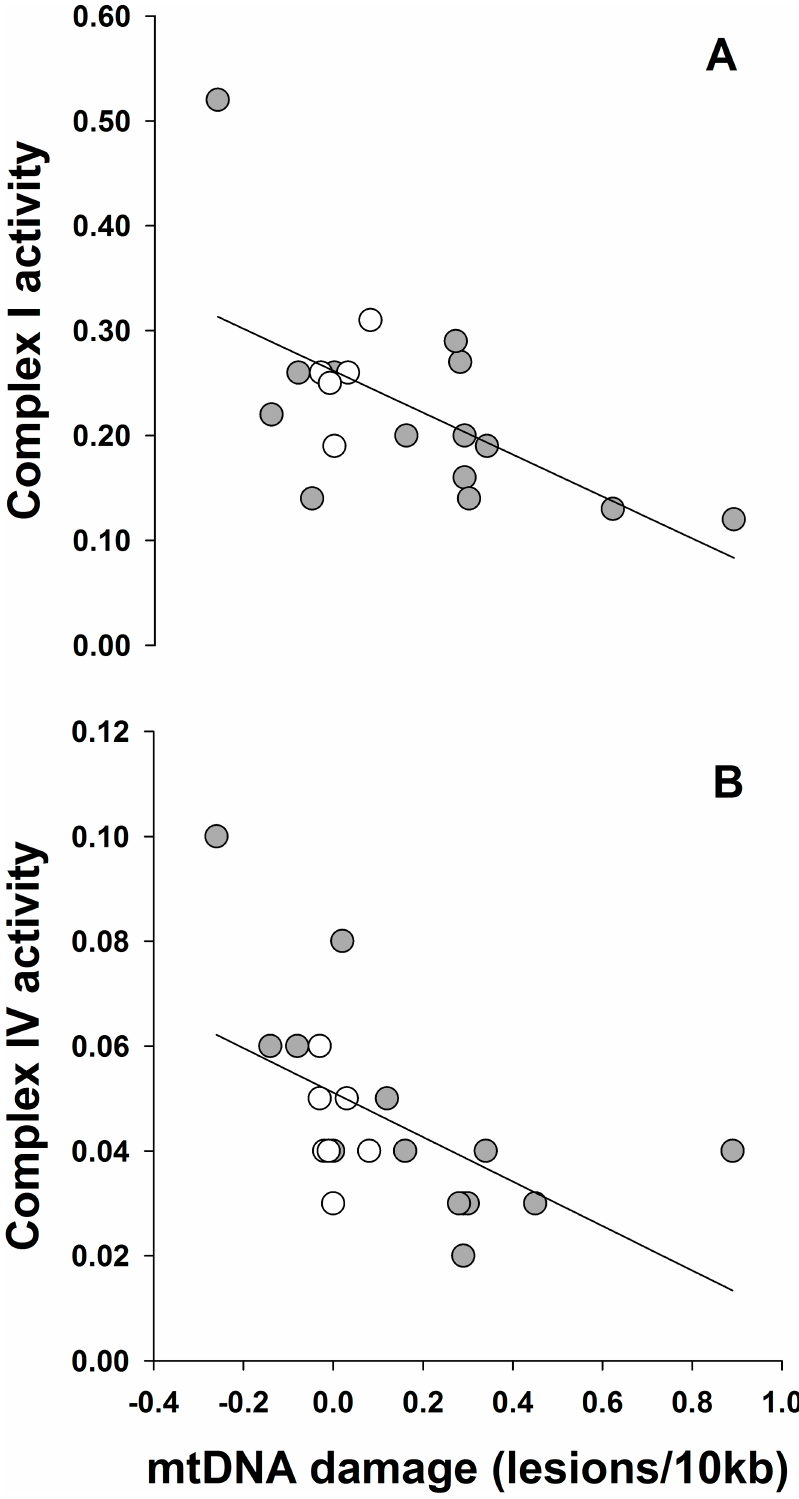
Fig 3. Mitochondrial DNA damage is associated with reduced Complex I and IV enzyme activity. Mitochondrial complex I activity (A) and complexIV activity (B) for cases with GWI+ (filled circles) and controls (open circles) were plotted against mtDNA lesion frequency yieldingcorrelation coefficients of r 2 = 0.35 and 0.30 ( p < 0.01), respectively. https://doi.org/10.1371/journal.pone.0184832.g003 PLOS ONE | https://doi.org/10.1371/journal.pone.0184832 September 14,